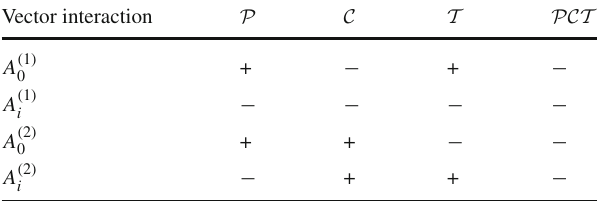
Table 1 Summary of the results for the behavior of the minimal and nonminimal vector interactions under P , C , T and PCT . Here “ + ” and “ − ” mean “no change sign” and “change sign”, respectively Vector interaction